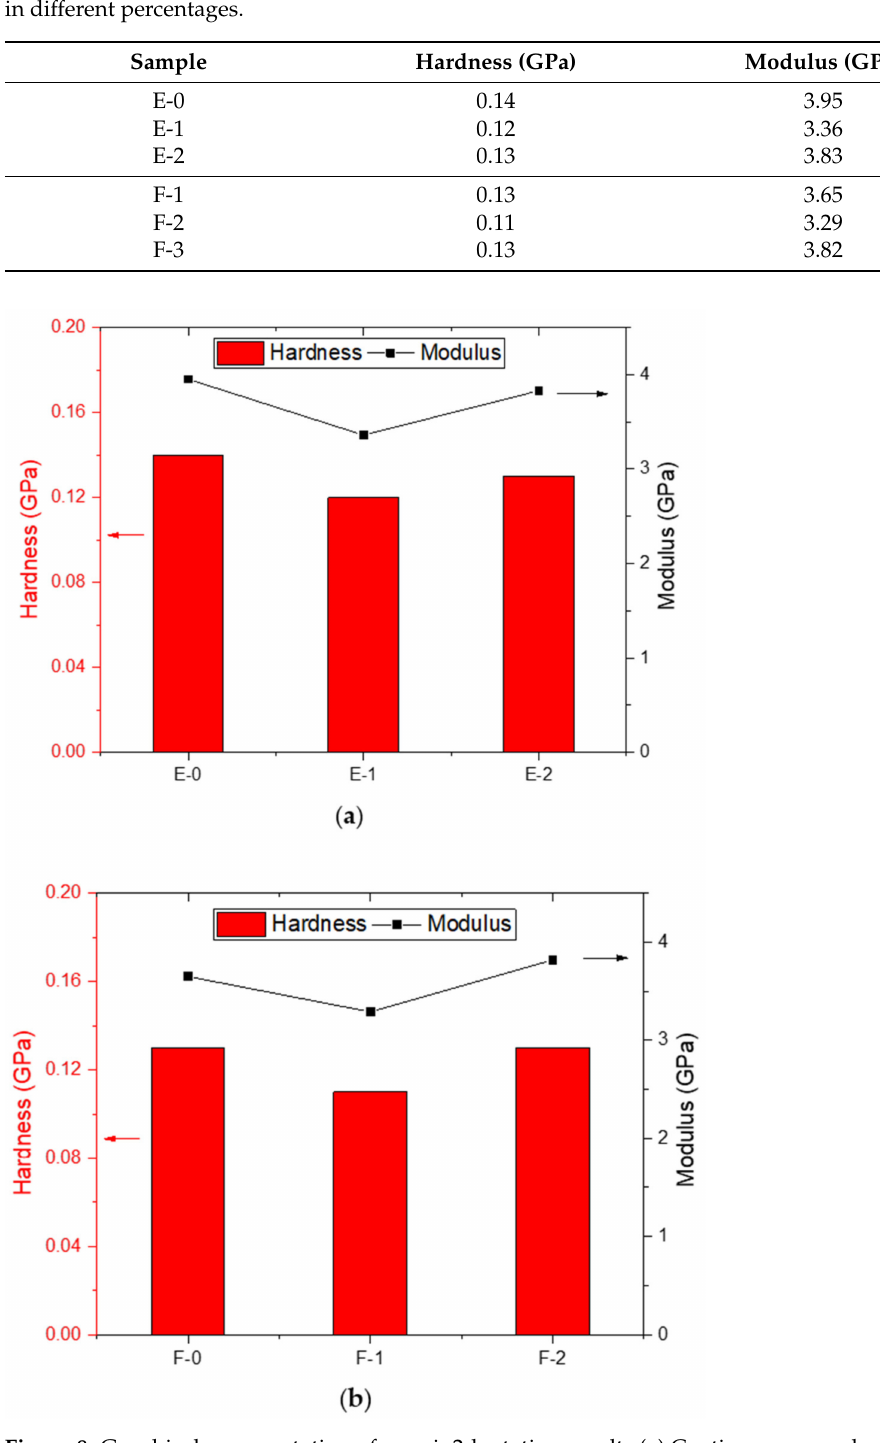
Figure 8. Graphical representation of nanoin2dentation results ( a ) Coatings prepared with PA-450 ( b ) Coatings prepared with